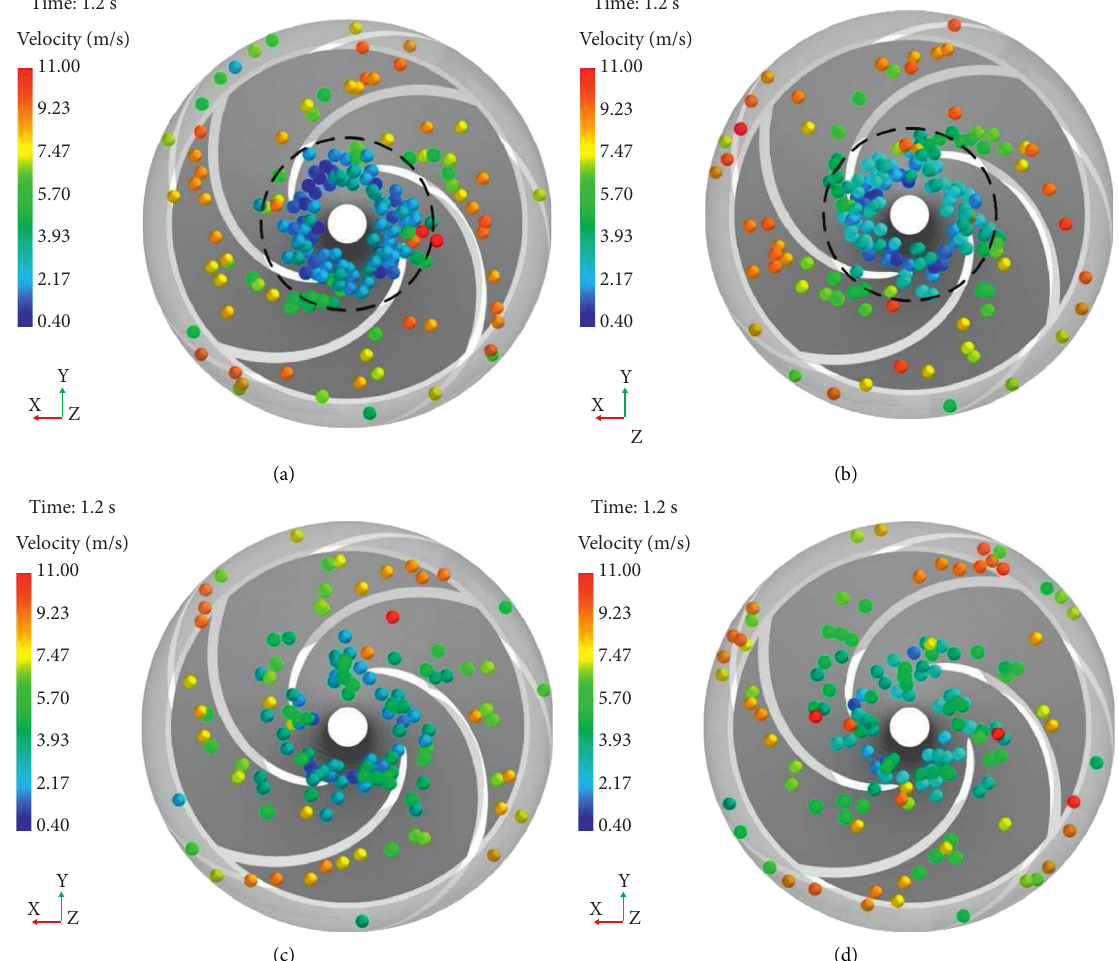
Figure 11: Distribution of particles in the cross section of the impeller at 1.2s at Q � Q d with or without leakage (the black circle marks the accumulation region in the first stage): (a) leakage, first stage; (b) no leakage, first stage; (c) leakage, second stage; (d) no leakage, second